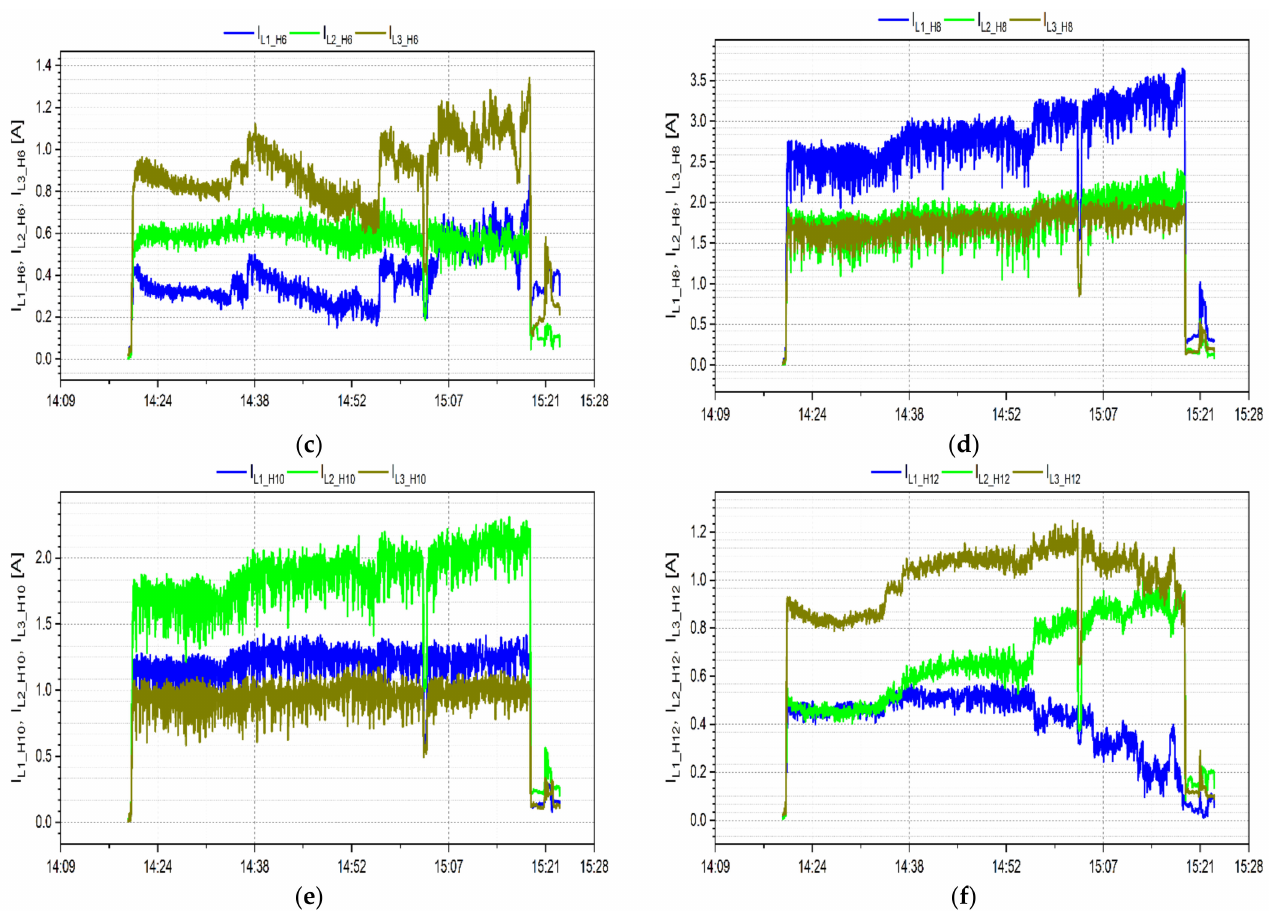
Figure 17. The individual harmonic current variation (150 cycles averaged): ( a ) 2nd harmonic, ( b ) 4th harmonic, ( c ) 6th harmonic, ( d ) 8th harmonic, ( e ) 10th harmonic, and ( f ) 12th harmonic during the full charging